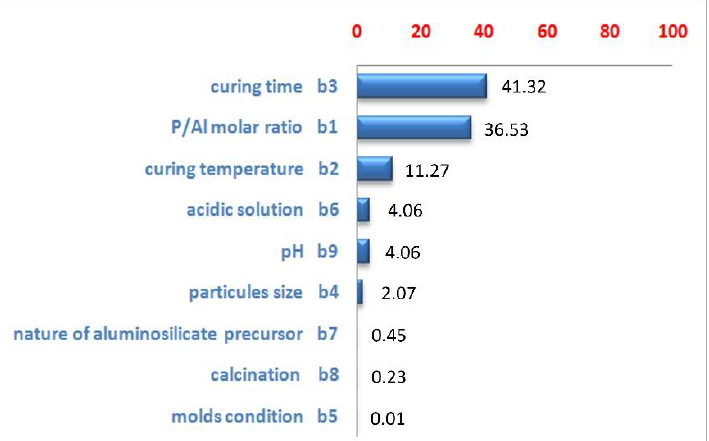
Table 7. Central composite experimental